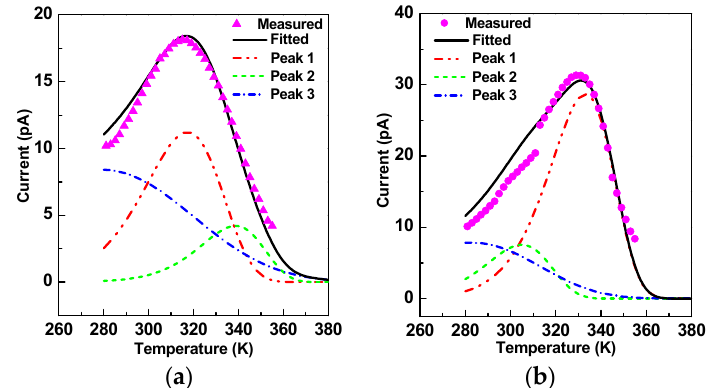
Figure 5. Measured TSDC curves and their fitted and separated peaks: ( a ) peaks of OP; ( b ) peaks of NP.